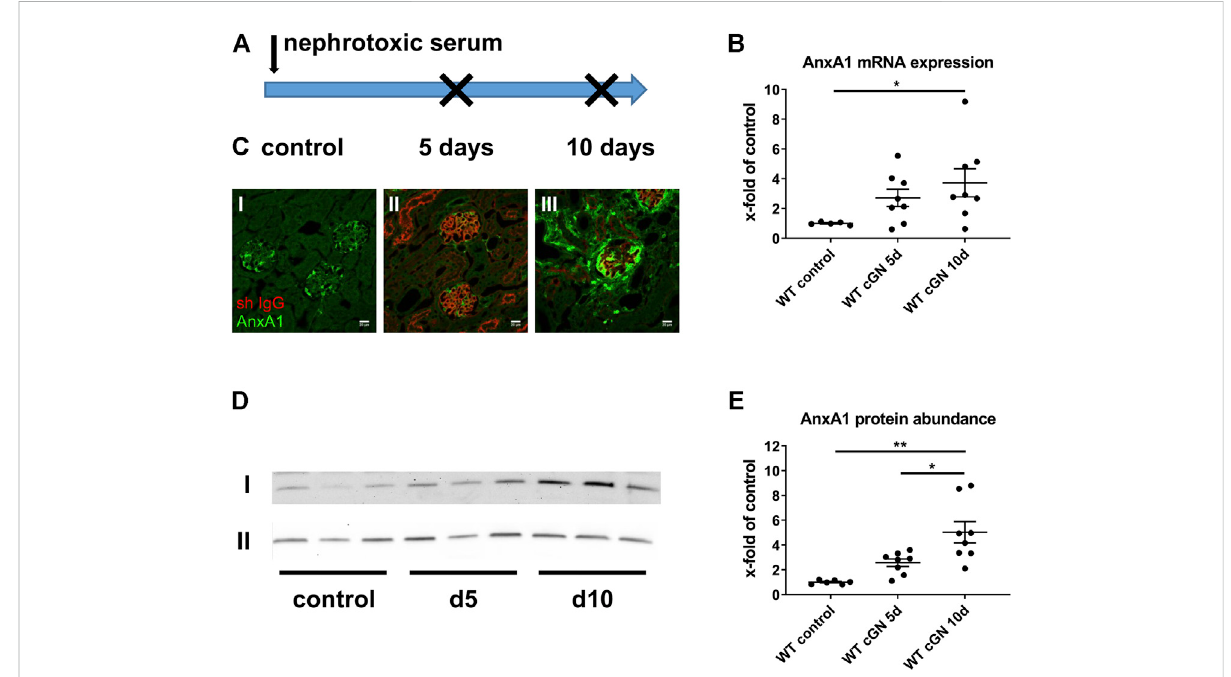
FIGURE 1 Regulation of annexin A1 during experimental crescentic GN. (A) Schematic of experimental setup. Crescentic glomerulonephritis (cGN) was inducedatd0inwildtype(WT)andannexinA1(AnxA1)-de fi cientmicebyintraperitonealinjectionofsheepnephrotoxicserum;animalsafterinjection of normal sheep serum served as controls. Kidneys were harvested at d5 and d10 after cGN induction. (B) TaqMan ® real time RT-PCR quanti fi cation of AnxA1 mRNA abundance in WT mice. (C) Representative micrographs showing immuno fl uorescence staining for AnxA1 (green) and sheep IgG (red) in controls (I) and in mice at 5 (d5; II) and 10 (d10; III) after cGN induction. Scale bar = 20 μ m. (D) Representative images of Western blots of WT mice treated with control or nephrotoxic serum for 5 (d5) and 10 days (d10). The β -actin content of the tissue homogenates was determined in parallel and served as loading control (lane II). (E) Densitometric analysis of the signals in (D) . Quantitative data in B and D is shown as x-foldchanges in relation to controls. Dots represent measurements from individual mice; horizontal lines indicate mean values and error bars represent the SEM. Statistical signi fi cance of changes was calculated using one-way ANOVA and indicated by * for p < 0.05 and ** for p < 0.01; n = 5 – 8 per